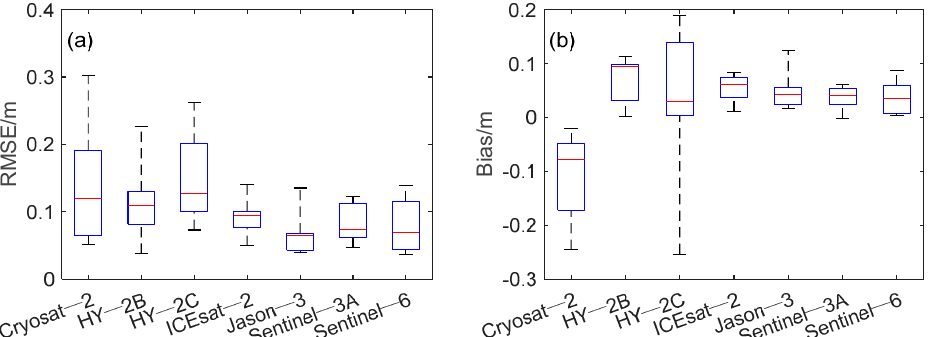
Figure 7. Box plot of RMSE ( a ) and bias ( b ) between seven altimetry measured water levels and in-situ data for the Great Lakes during all acquisition times. The top and bottom of each box show the 25th and 75th percentiles of the RMSE and bias, and the red line in the middle of the box shows the median (50th percentile). The two whiskers extend to the farthest outlying RMSE and bias represents the maximum and minimum values of RMSE and bias.